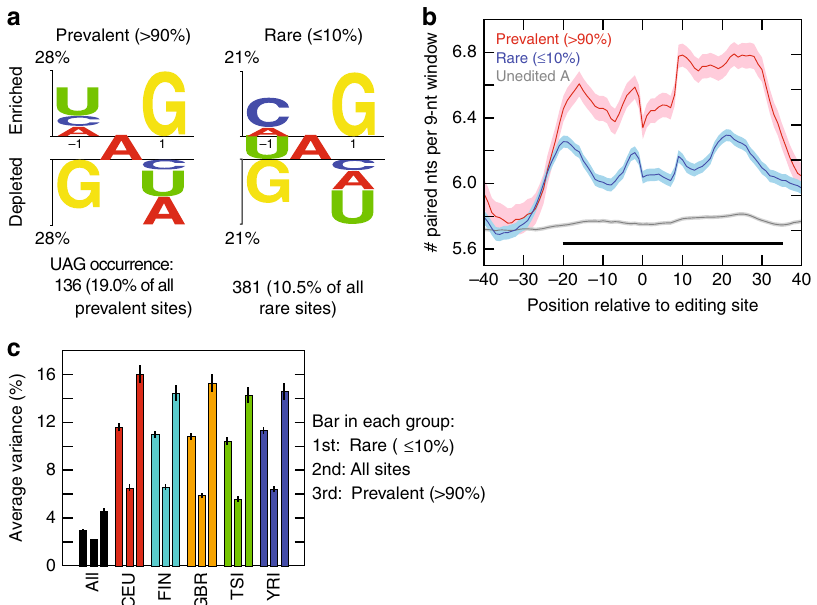
Fig. 2 Comparison of prevalent and rare editing sites. a Sequence preference for positions fl anking prevalent and rare A-to-I editing sites, represented using a two-sample logo program 69 . A total of 714 prevalent (prevalence > 90%) and 3618 rare (prevalence ≤ 10%) editing sites were included, respectively. The number of occurrences of the ‘ UAG ’ motif is shown below each graph. The ‘ UAG ’ sequence is signi fi cantly enriched around prevalent sites compared to rare sites ( p = 1.4e-9, Fisher ’ s Exact test). Prevalent and rare editing sites were de fi ned using editing sites of the union of all individuals (same below). b Average number of paired nucleotides in a sliding window of 9 nucleotides (corresponding to the length of ADAR binding region 70 ) near prevalent (red) and rare (blue) editing sites, and near random adenosines (gray) located 200 – 300 nucleotides from editing sites. Shaded areas represent the standard error of the mean. Horizontal black bar indicates the region where there are signi fi cant differences between the numbers of paired nucleotides around prevalent and rare editing sites ( p < 0.01, Wilcoxon Rank-Sum test). c Variance in editing levels across individuals explained by ADAR expression levels ( ADAR1 , ADAR2 , and ADAR3 ) in a linear model. Average values of rare (3618 sites), all (8080) and prevalent sites (714) are shown (ordered as the 1st, 2nd, and 3rd bar in each group, respectively). Error bars represent con fi dence